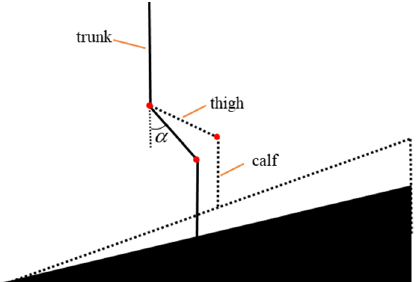
Figure 6. The ultimate angle of the thigh on different slopes. According to the above analysis, there are slight differences in the angle of the lower limbs on different slopes. In order to explore the feasibility of using the EMG signal to identify road slope. In this paper, the EMG signals of the lower limbs of the test subjects, walking on different slopes, were collected via the BIO-8 system (equipment for collecting EMG signals). The EMG signals from three gait cycles are shown in Figure 7.